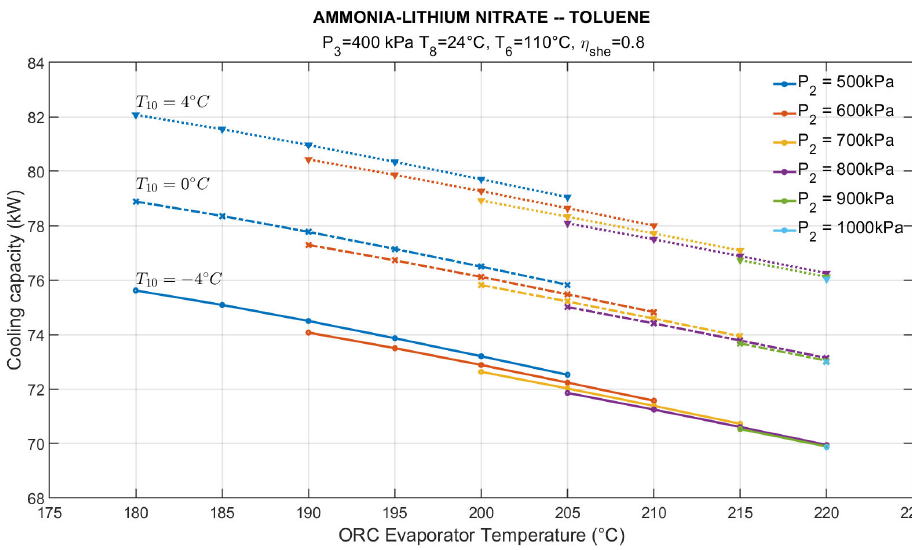
Figure 15. NH 3 -LiNO 3 --C 7 H 8 e ff ect of heat source and cooling temperatures on cooling load.